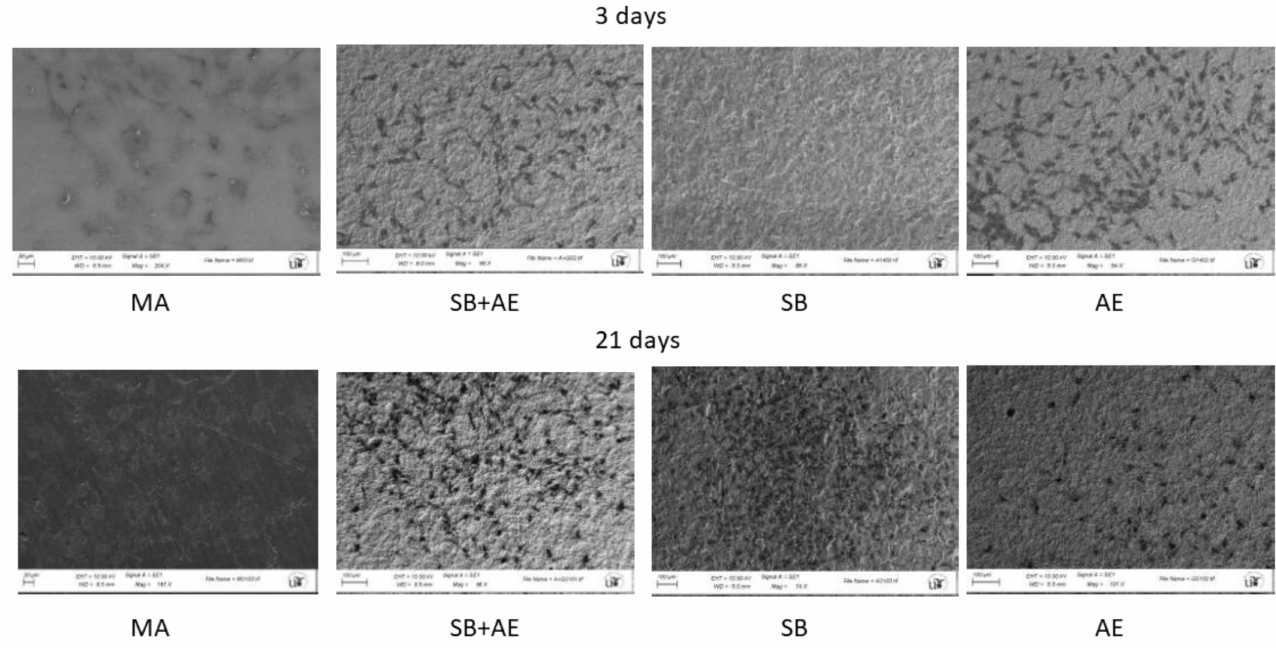
Figure 2. SaOS-2 osteoblastic cells viability at 3 and 21 days for the different topographies studied. Each symbol indicates the statistical differences’ significance p < 0.001.